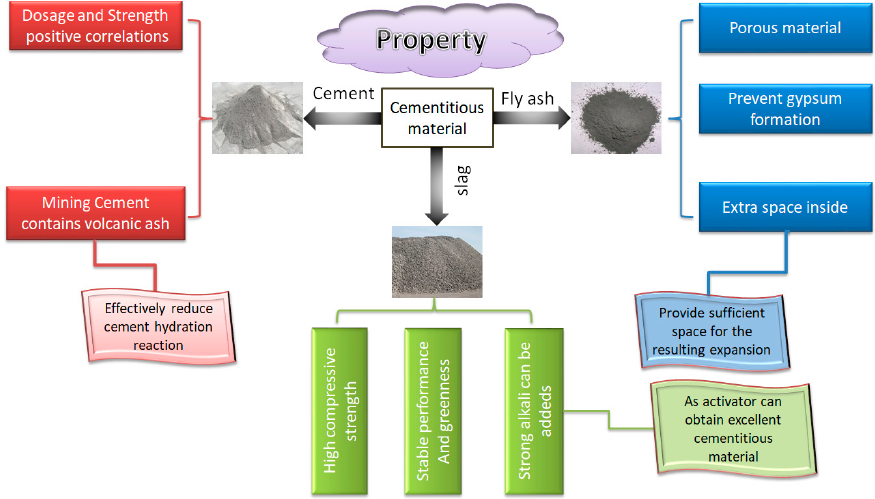
Figure 18. Properties of three kinds of cementitious material.